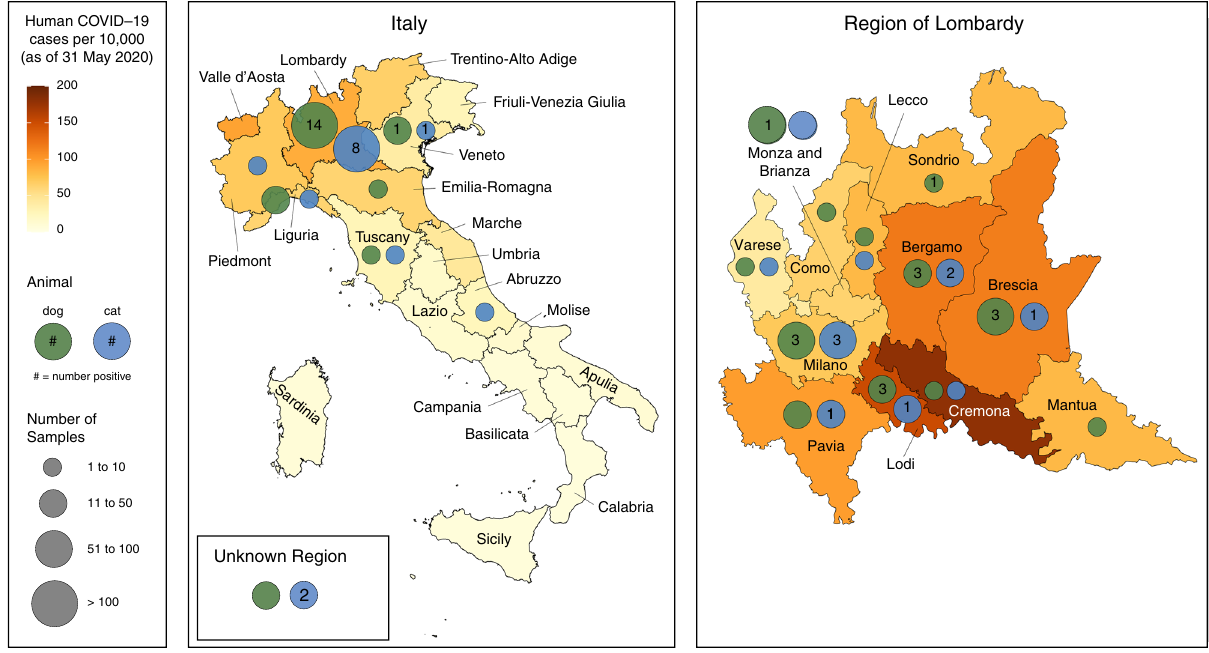
Fig. 1 Distribution of dog and cat samples assayed for neutralizing antibody titer across Italy and the region of Lombardy. Data on human COVID-19 cases from the Italian Department of Civil Protection as of 31 May 2020 and population data from the Italian National Institute of Statistics (ISTAT), January 2019. Source data are provided as a Source Data fi le.